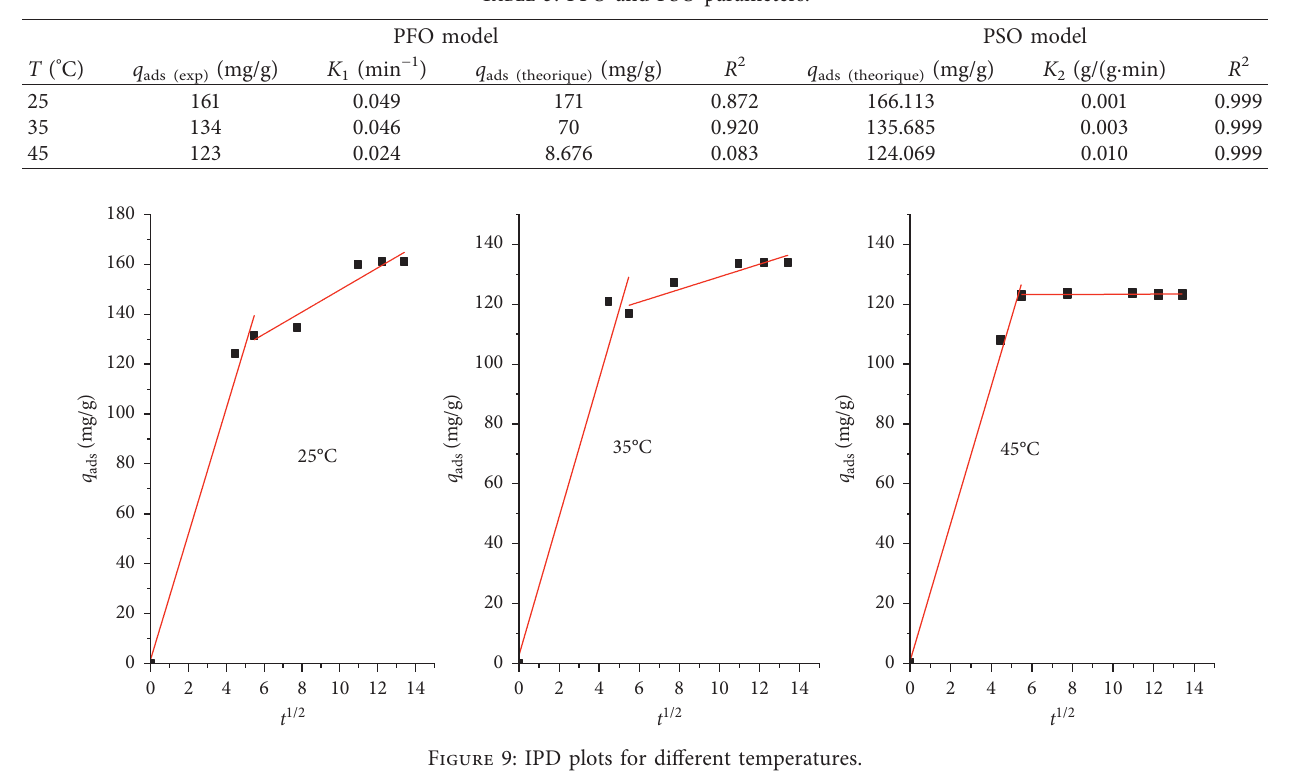
Figure 8: Linear portrayal of kinetic model of polyphenols adsorption onto Gh-B for both models (a) PFO and (b) PSO. Table 3: PFO and PSO parameters.